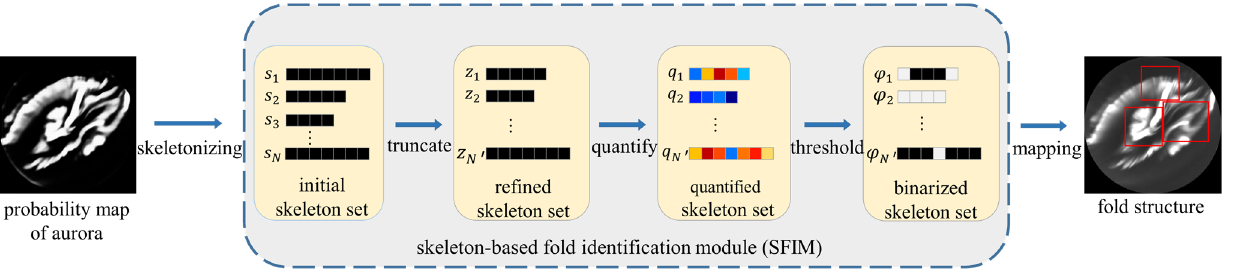
Figure 4. Identification of fold structure, where the rows and columns represent skeleton slices and skeleton pixels in each skeleton set of SFIM, respectively.